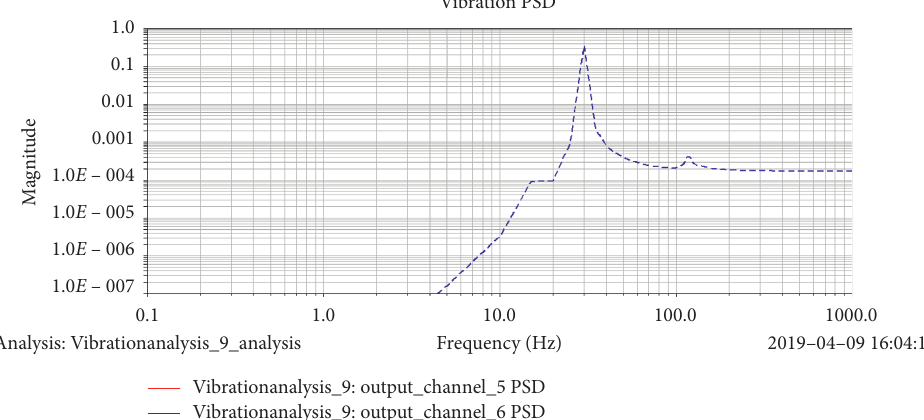
Figure 14: The vertical acceleration power spectral density curve of the centroid of the spreader.